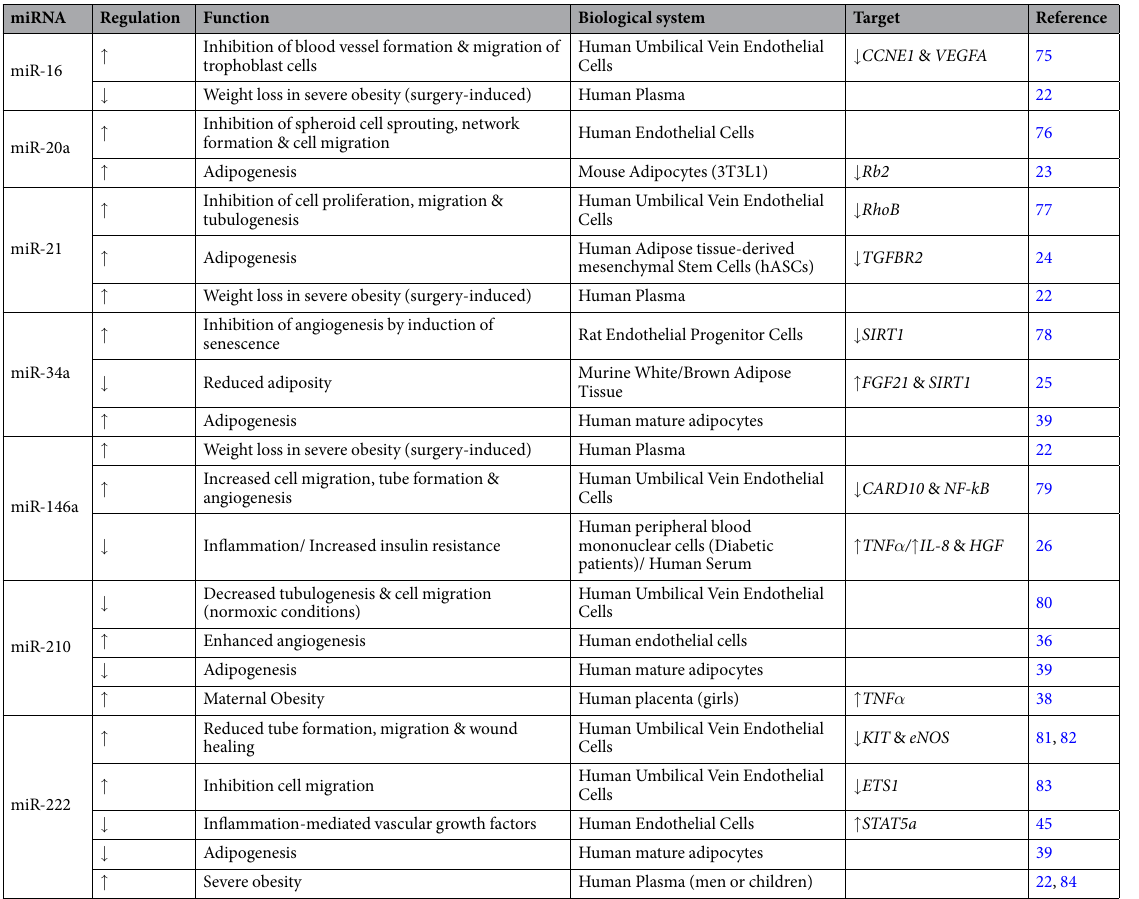
Table 5. Measured miRNAs related to key processes implicated in obesity. CARD10 : Caspase Recruitment Domain Family, Member 10, CCNE1 : Cyclin E1, eNOS : endothelial Nitric Oxide Synthase 3, ETS1 :